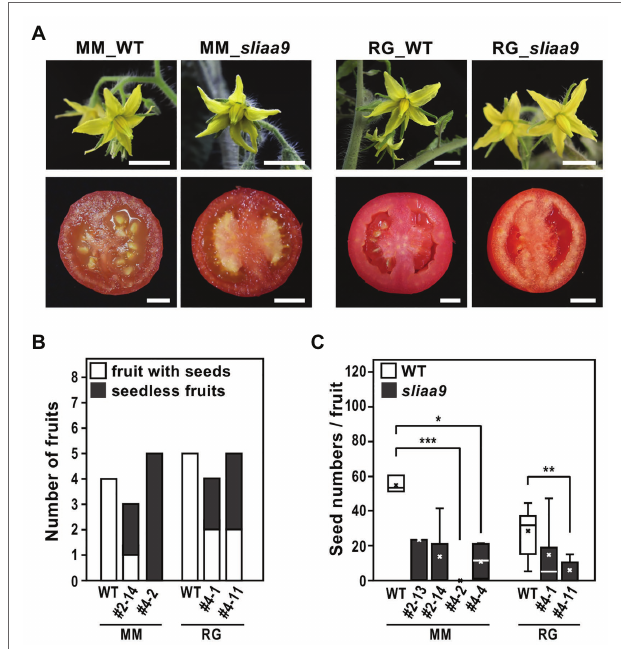
FIGURE 4 | Flowers and fruits phenotypes of sliaa9 mutants. (A) The representative T2 flower (upper, MM_ sliaa9 ; MM#2-13-1, RG_ sliaa9 ; and RG#4-1-1) and T0 fruit (bottom, MM_ sliaa9 ; MM#4, RG_ sliaa9 ; and RG#4) phenotypes of the sliaa9 mutants of Moneymaker (left) and Rio Grande (Right). Bars = 1 cm. (B) Number of seedless mature fruits developed without pollination (parthenocarpic fruits) and all the fruits obtained from sliaa9 T1 mutant lines (MM#2-14, MM#4-2, and RG#4-1, and RG#4-11) grown under low light for 5 months. (C) Seed numbers of sliaa9 T1 mutant lines (MM#2- 13, #2-14, #4-2, and #4-4) of Moneymaker and Rio Grande (RG#4-1, and #4-11). Average seed numbers were calculated in the mutant fruits ( n = 3–12) without pollination and in wild-type (WT) fruits ( n = 5–12) with pollination. * p < 0.05, ** p < 0.01, and *** p < 0.001 are determined by Student’s t